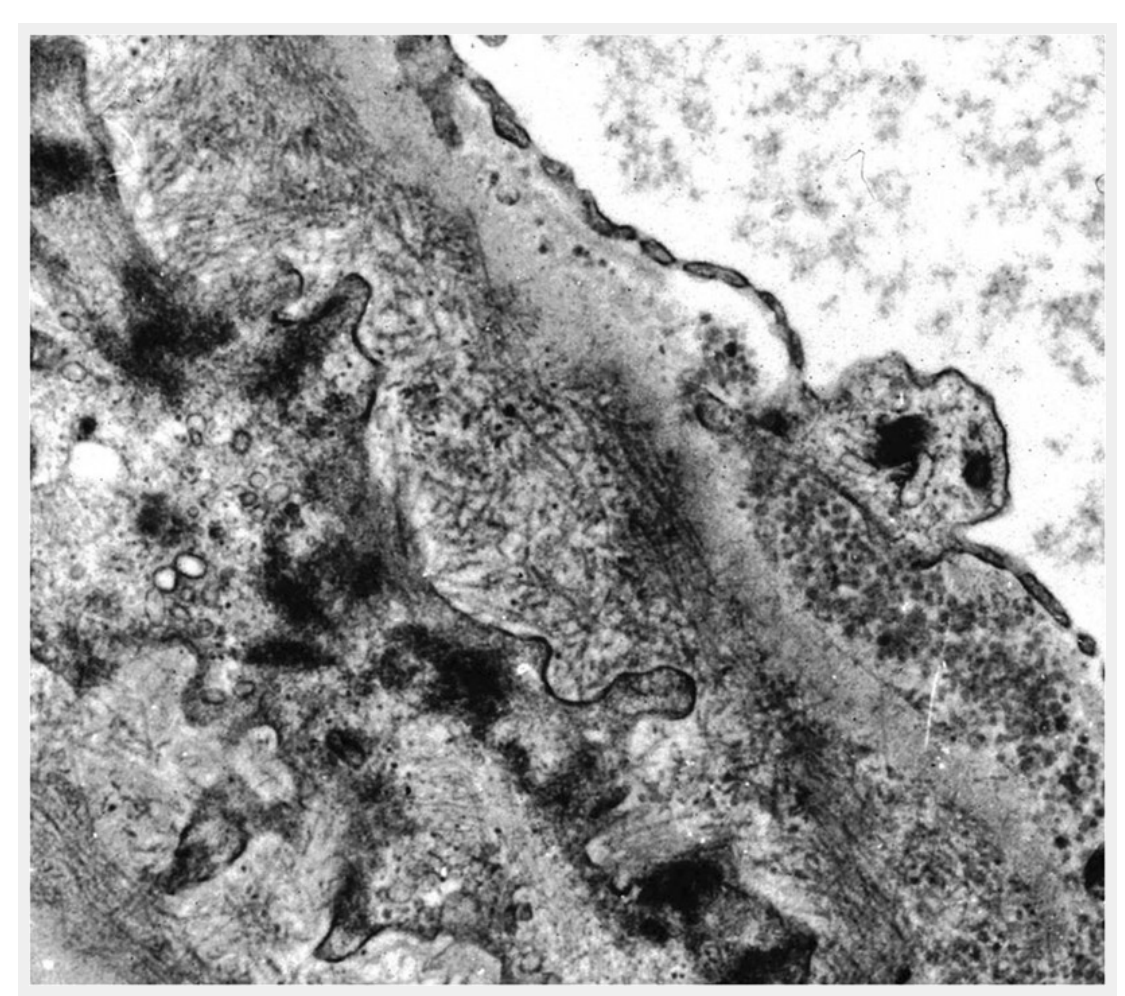
Figure 1 Electron microscopy: peripheral basement membrane with randomly arranged fibrillary